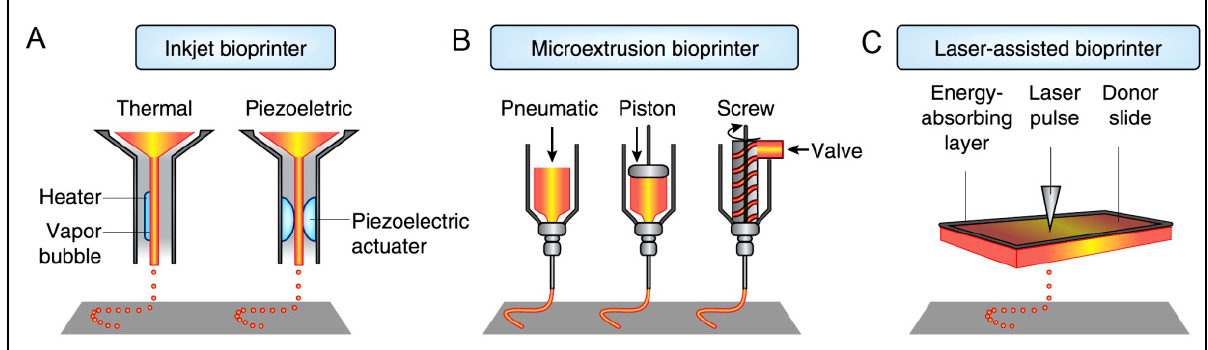
Figure 5. Schematic representation of different types of bioprinting technologies. Reprinted with permission from Ref. [181] , Copyright 2014, Nature Publishing Group.